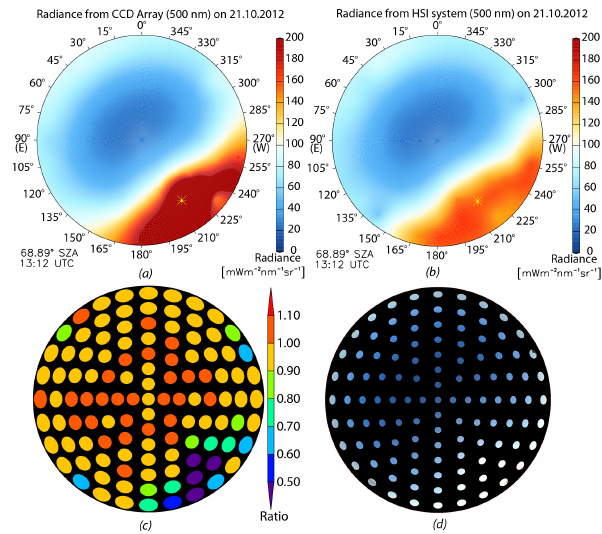
Figure 4. Spectral radiance distribution at 500nm measured by (a) CCD spectroradiometer and (b) HSI system on 21 October 2012 at 13:12UCT (68.89 ◦ of solar zenith angle (SZA)) for cloud-free condition. (c) Ratio between the computed spectral radiance of the HSI system and the measured spectral radiance of the CCD spec- troradiometer (HSI system/CCD spectroradiometer). Although the FOV of the scanning pattern is 5 ◦ (see d ), the scanning points show- ing the ratio are plotted with a FOV of 10 ◦ for clarity of the presen- tation. The synchronized HSI image showing the 5 ◦ FOV pattern of the scanning points from the CCD spectroradiometer is illustrated in (d)